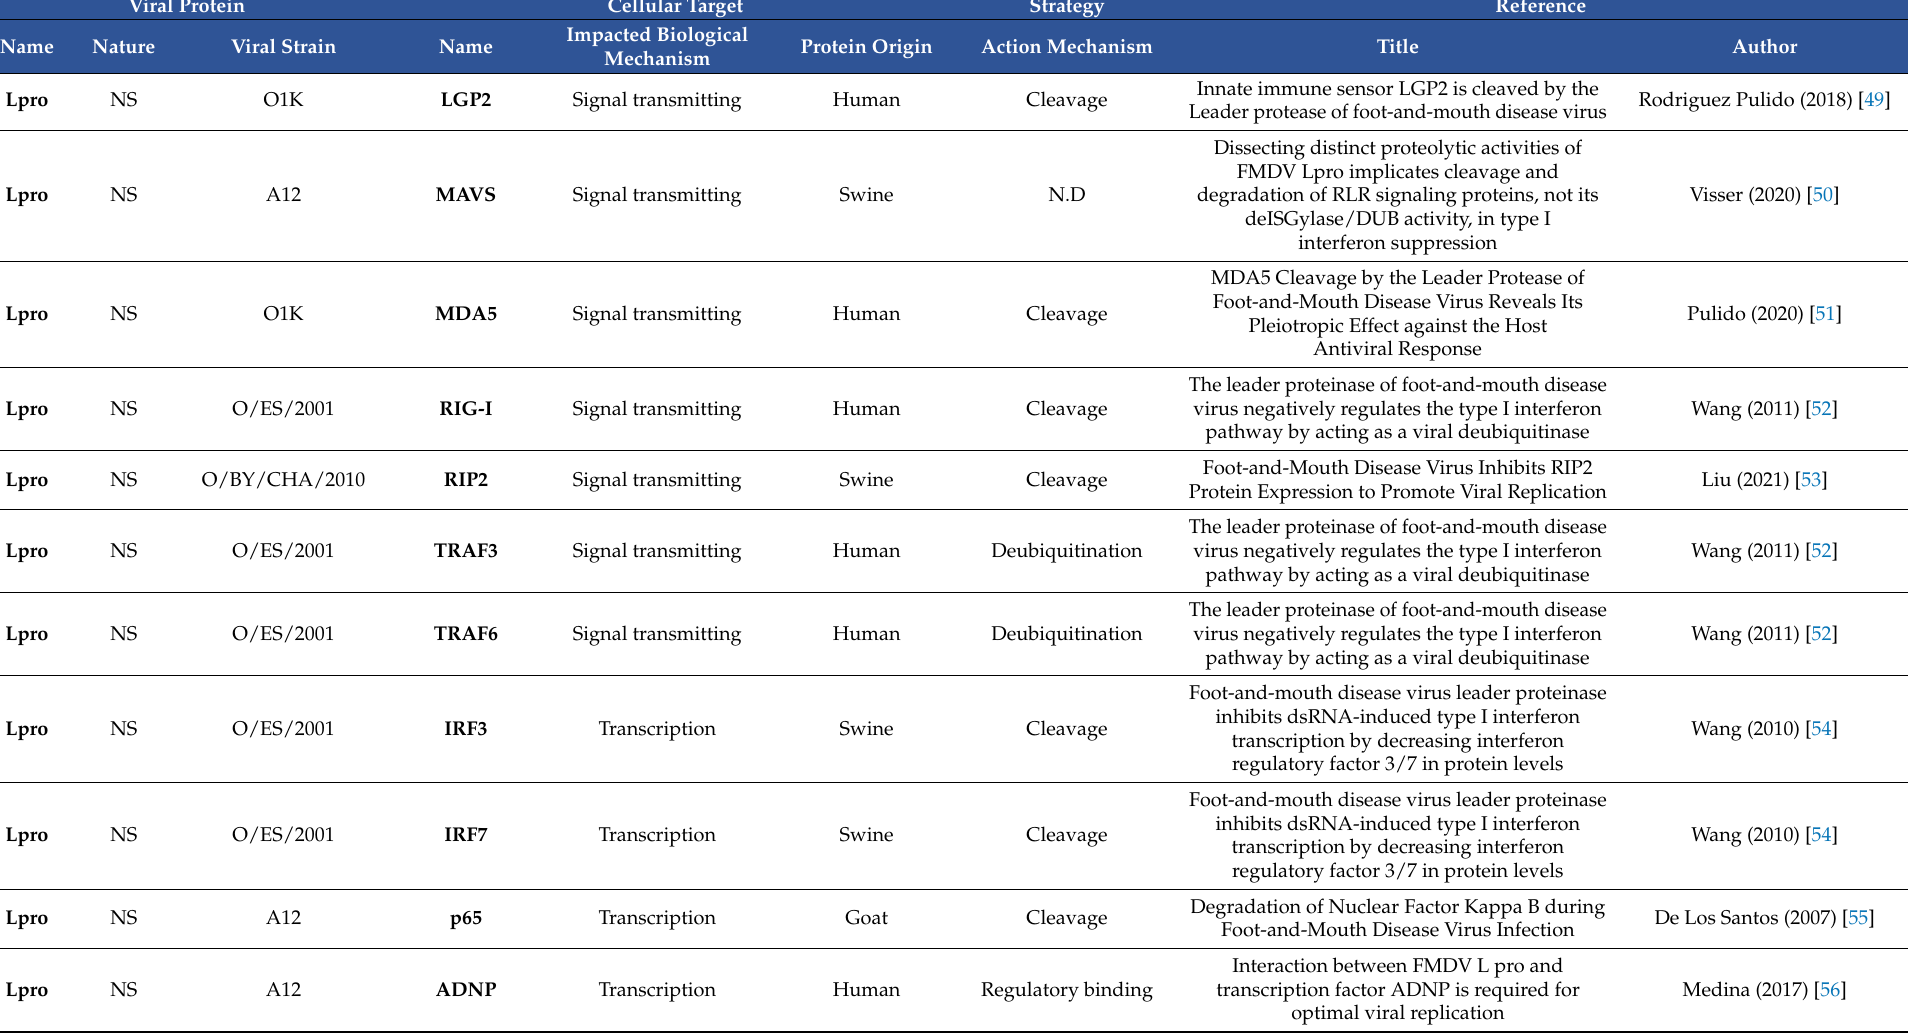
Table 1. Protein–protein interactions described between FMDV 3D polymerase and type I IFN